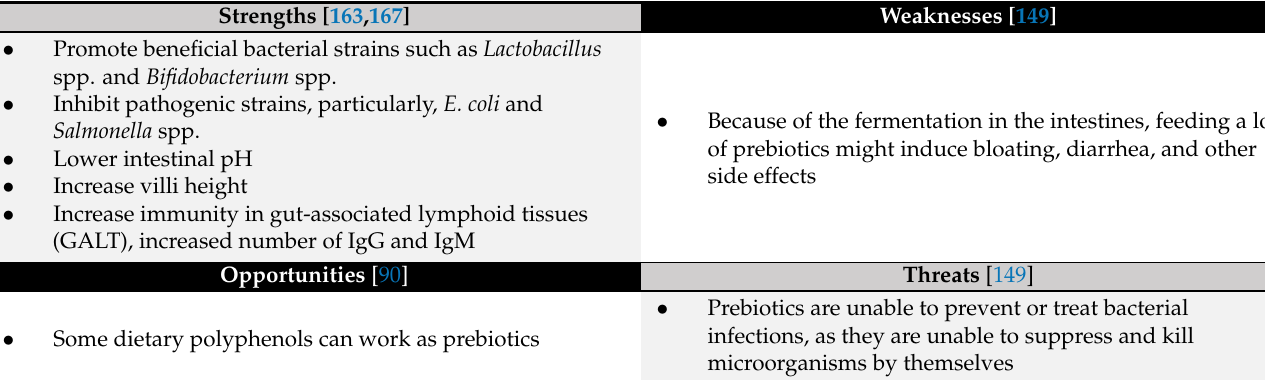
Table 6. SWOT analysis of